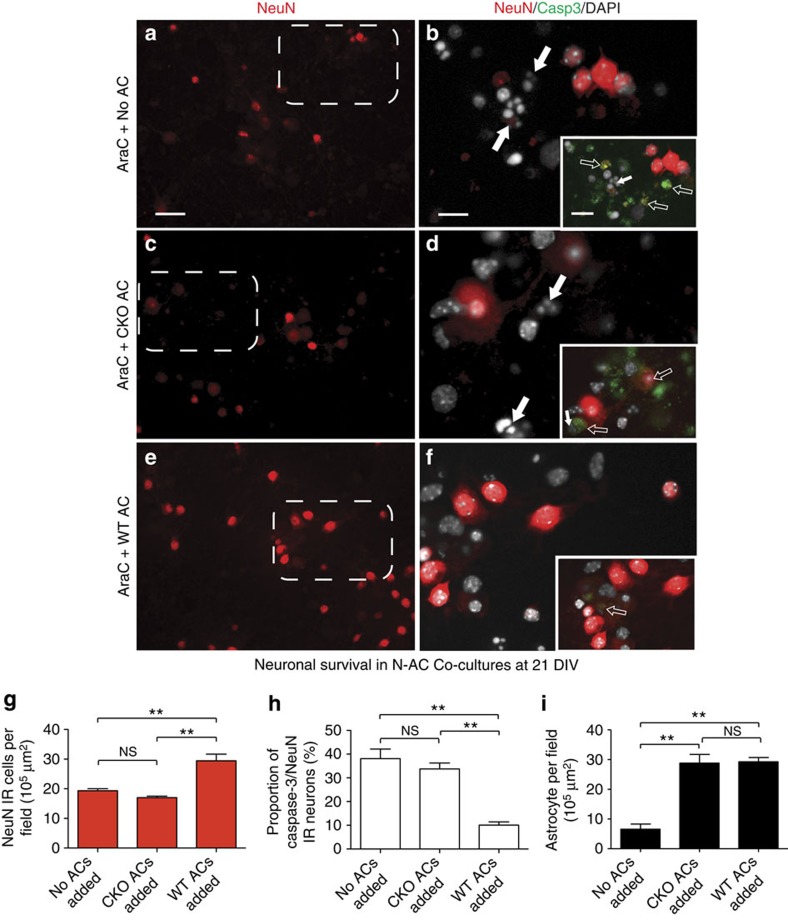
Astrocytic STAT3 supports neuronal integrity independently of other cell types in vitro.(a–f) Fluorescent images of NeuN/DAPI co-labelled cells in purified neuronal cultures in the near absence of ACs (a,b) and in the presence of CKO ACs (c,d) or WT ACs (e,f). Examples of pyknotic cells (full arrows, b,d). Insets illustrate the same areas with activated caspase-3/NeuN co-labelling. Activated caspase-3-positive neurons with reduced NeuN immunoreactivity (empty arrows) are prevalent in the ‘no added AC’ (b) and CKO AC (d) conditions. Some activated caspase-3-positive cells are already pyknotic (small arrows) and/or disintegrated into debri (empty arrows). (g) Mean number of surviving NeuN IR neurons per experiment at 21 DIV (n=3 cultures per 9 fields each, **P<0.01, one-way analysis of variance (ANOVA) P=0.0016). (h) Mean percentage values of NeuN IR neurons that are also co-labelled for activated caspase-3. (i) The numbers of WT and CKO ACs surviving at 21 DIV were comparable. Only a small number of WT ACs remained in the ‘no added ACs’ group after AraC treatment (for h and i: n=3 cultures per 9 fields each, **P<0.01, one-way ANOVA P=0.001). Scale bar, 30 μm for a,c,e; 10 μm for b,d,f and for insets. Data represent mean±s.e.m.